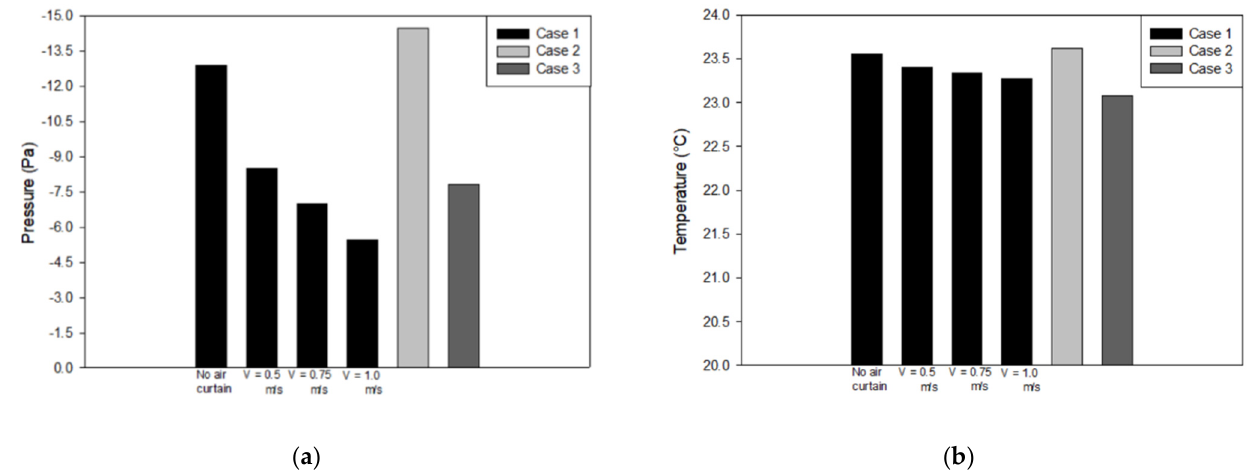
Figure 7. Various cases based on locations of exhaust air: ( a ) pressure; ( b ) temperature.